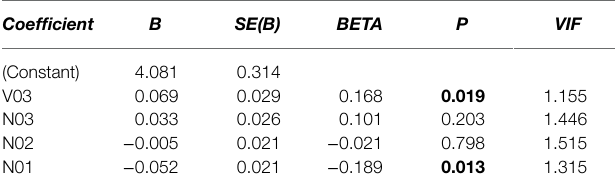
TABLE 7 | Multiple regression with GCL and cognitive abilities ( n = 222).